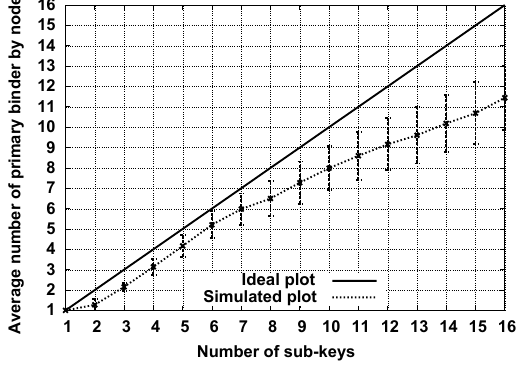
Figure 9. Scatter plot of distributed directories system.